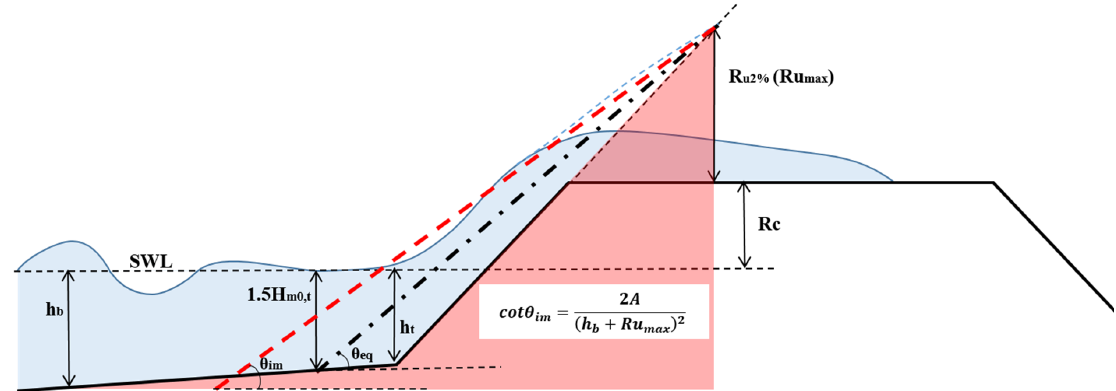
Figure 2. Scheme for definition and calculation of equivalent slope (Altomare et al., 2016) and imaginary slope (Mase et al., 2013). For the latter, the area A shadowed in red is employed.